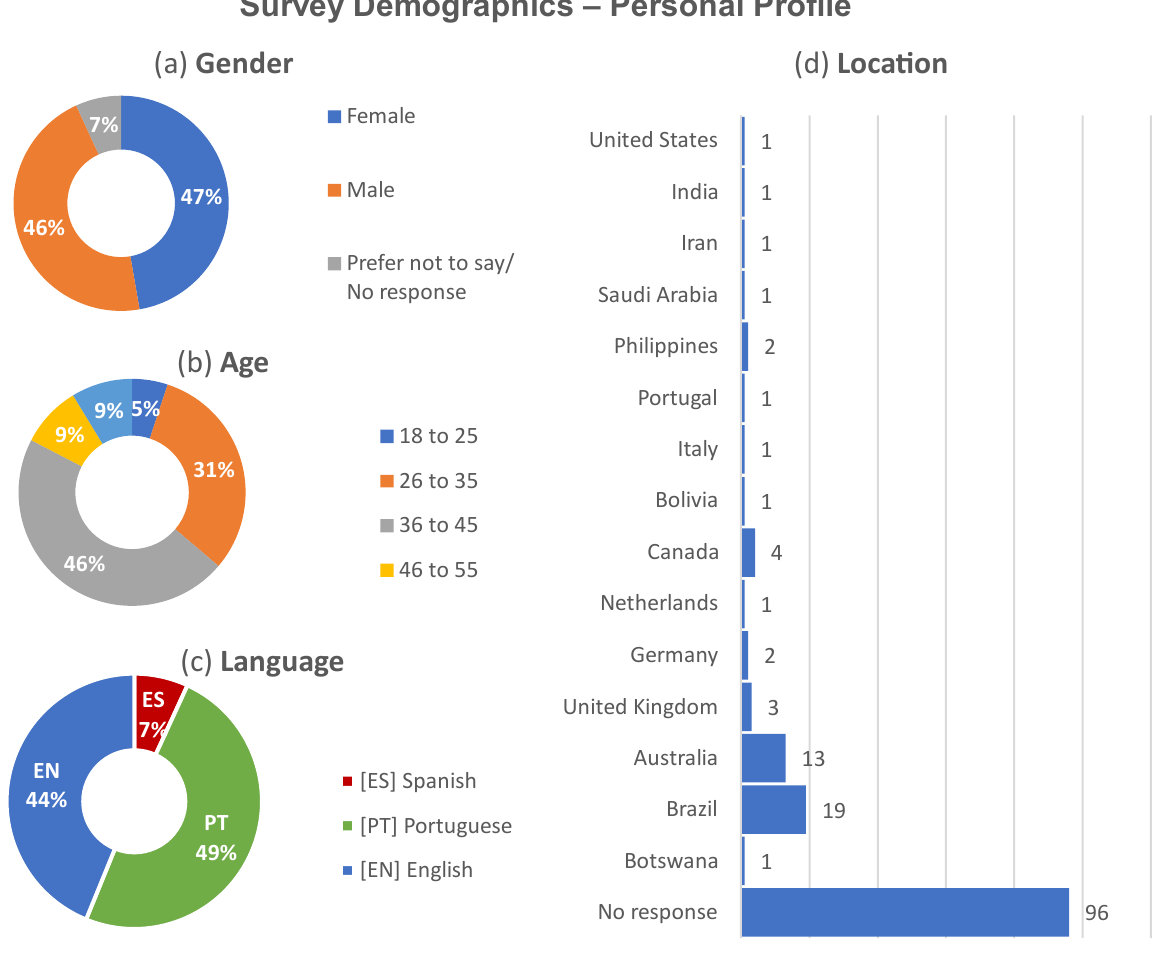
Figure 3. Demographics: personal profile of survey respondents regarding ( a ) gender, ( b ) age, ( c ) language, and ( d ) location.